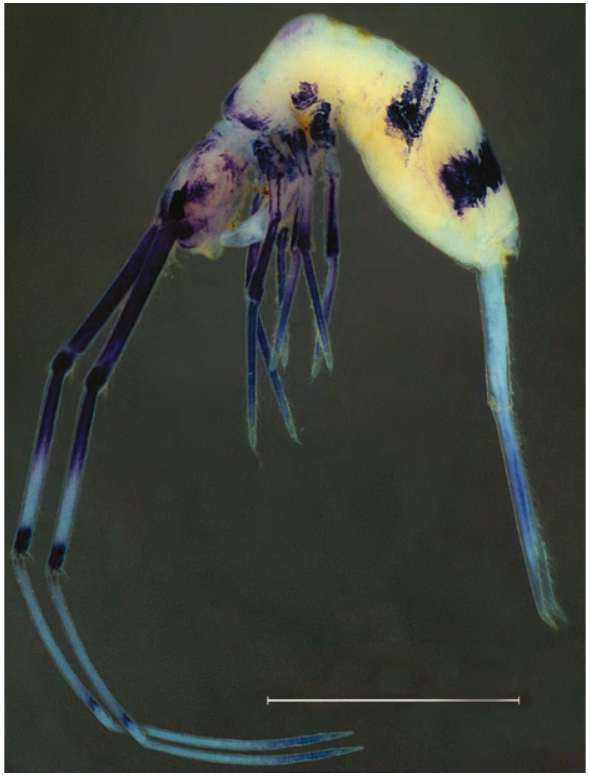
Figure 1. Campylothorax viruaensis sp. nov. , habitus of a fixed specimen in ethanol. Scale bar: 1